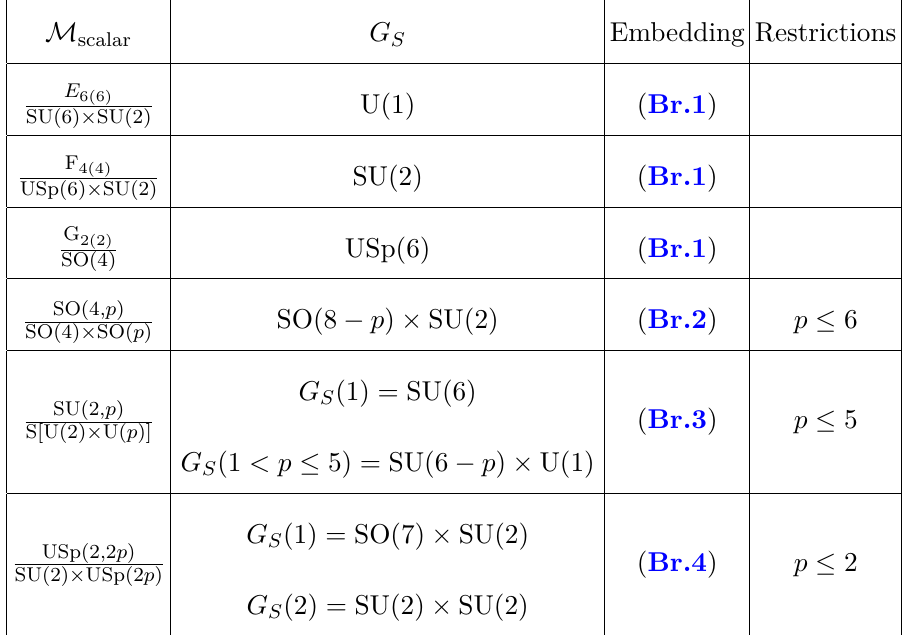
Table 2 . Summary of the possible truncations to N = 4 gauged supergravities, leading to a single quaternionic-Kähler manifold. G S denotes the structure group, with the notation G S ( p ) where there is a family of scalar manifolds, labelled by p and M scalar is the scalar manifold. We also list the embeddings of G S ⊂ SO(12) and give restrictions on the integer p , where relevant.